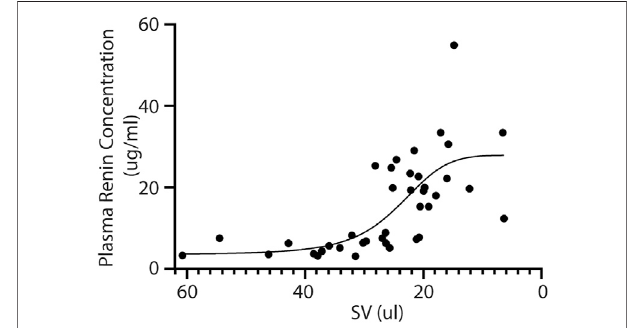
FIGURE3| Plasmareninconcentrationincreasesuponreducedcardiac function. In line, the plasma renin levels are signi fi cantly correlated to a lower stroke volume after TAC (R2 (cid:1) 0.45 and p (cid:1) < 0.0001). SV; Stroke volume.